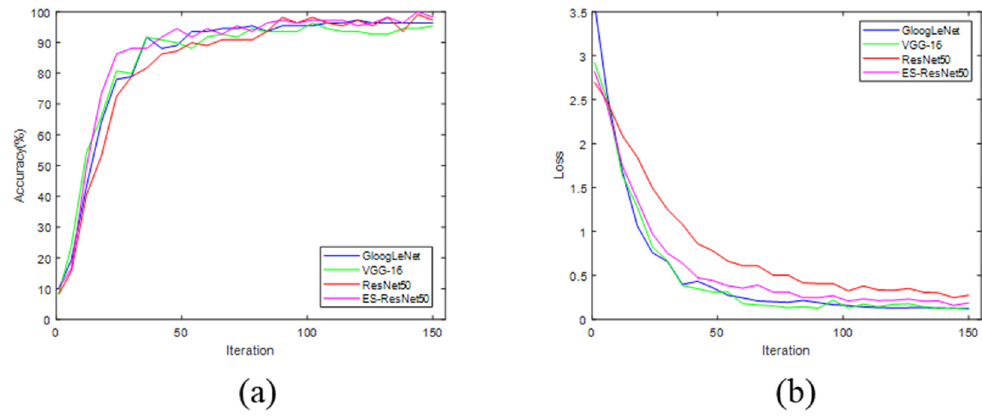
Figure 13. The comparison of convergence speeds of four network structures, where ( a ) is validation accuracy curve and ( b ) is the validation loss curve.